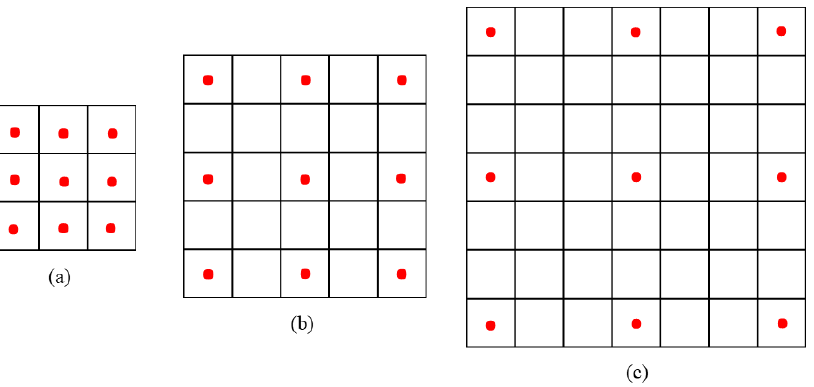
Figure 1. The RF of different dilation rates at 3 × 3 filter. ( a ) Dilation rate = 1, the RF is 3 × 3. ( b ) Dilation rate = 2, the RF is 5 × 5. ( c ) Dilation rate = 3, the RF is 7 × 7.